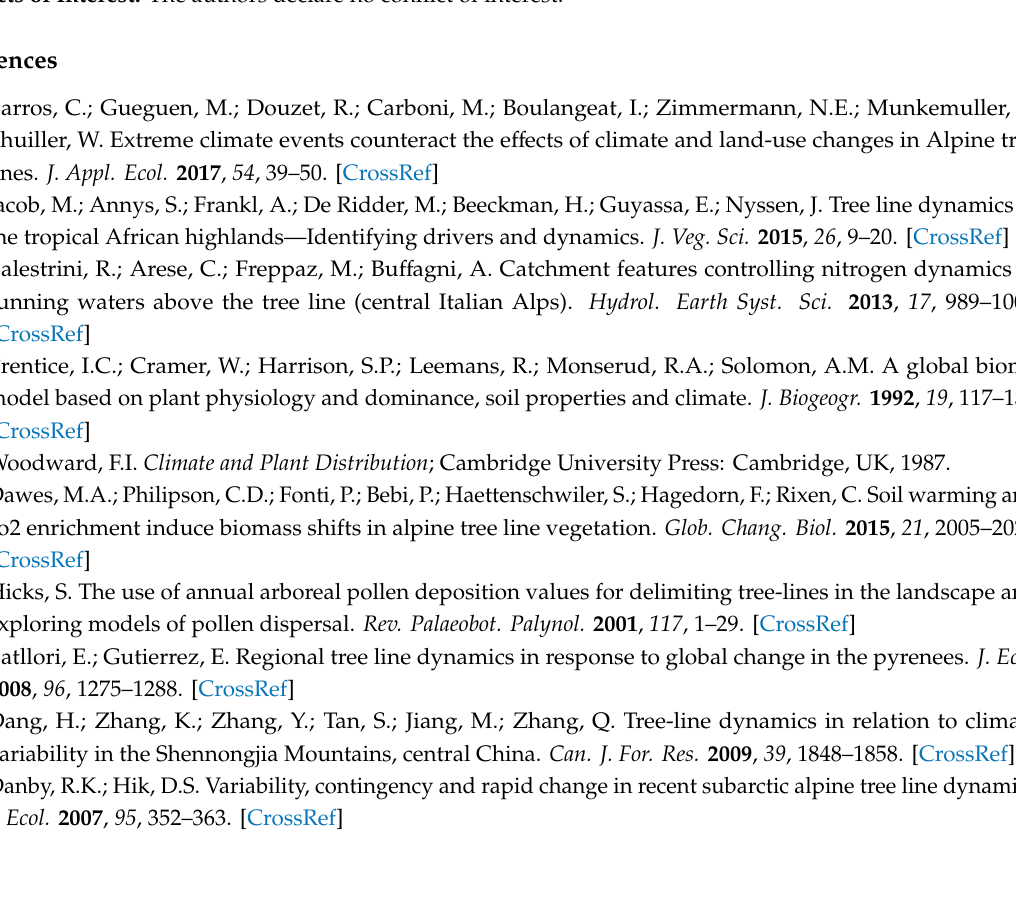
Figure S1. Cloud and cloud shadow e ff ects on automatic tree line extraction from Landsat images; Supplement A: Tree line extraction by NDVI from all Landsat images; Supplement B: Accuracy assessment with reference to RGB image with a spatial resolution of 0.53 × 0.53 m; Supplement C: Best extraction of tree line for each year from Landsat images; Supplement D: Comparison of tree line extraction from Landsat and RGB images with a 16.9 m spatial resolution; Supplement E: Sample statistics for testing topographic e ff ects, Python script,